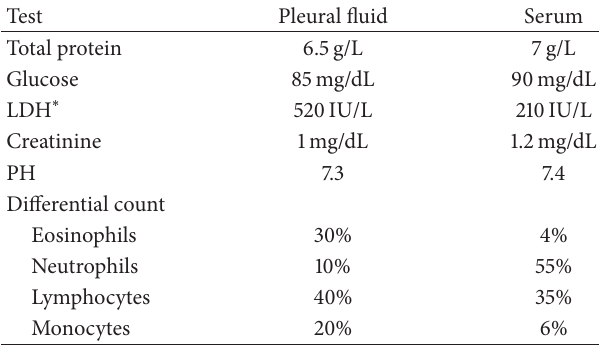
Table 1: Pleural fluid and serum biochemical data and differential